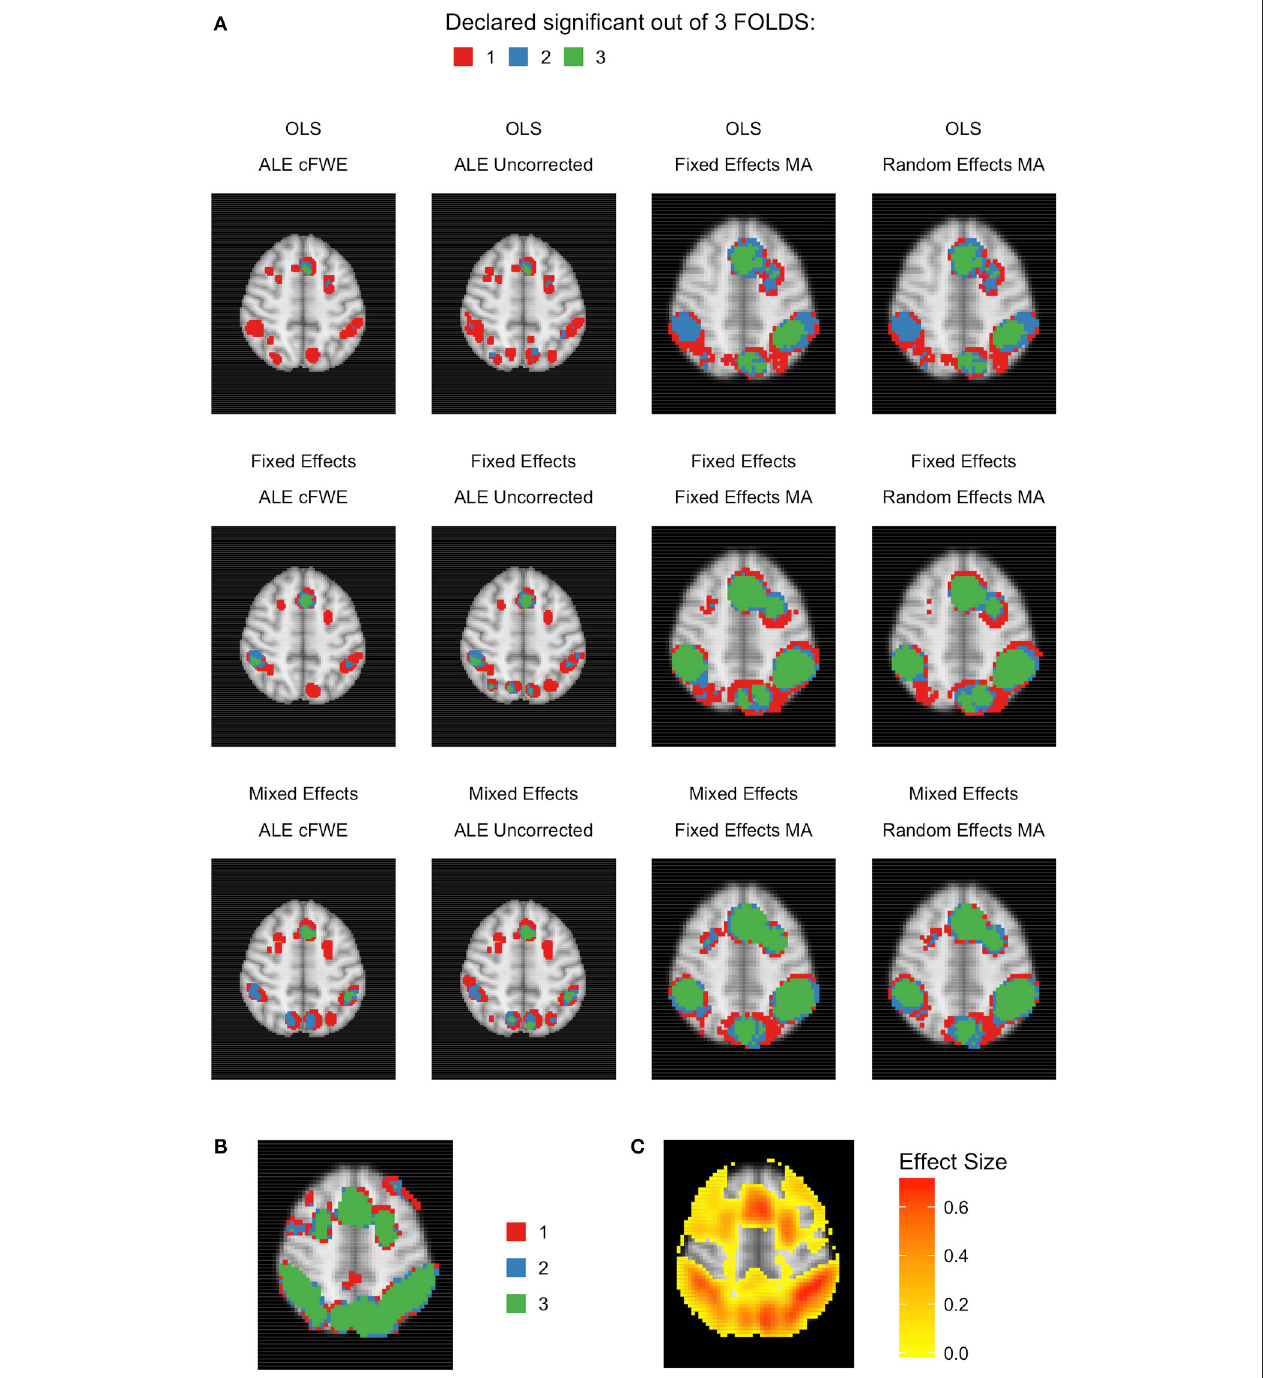
FIGURE 12 | Heatmaps of MNI z-coordinate 50 for K 20. (A) The number of folds in which each voxel has been declared statistically significant for each = combination of a group level model (row-wise) and thresholded meta-analysis (column-wise). Note that the resolution of the images corresponding to the analyses within either ALE or the fixed and random effects CBMA is different (see main text). (B) The number of folds in which each voxel of the reference images has been declared statistically significant. Areas of interest involve the supramarginal gyrus (posterior division), superior parietal lobule and angular gyrus. (C) Average effect size of the reference images over the